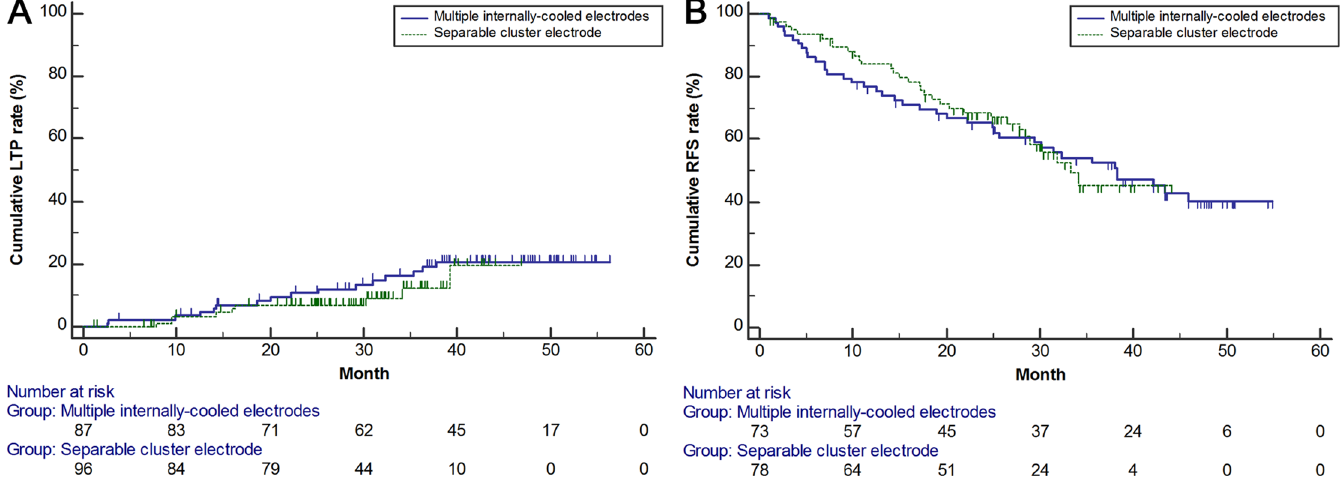
Fig 5. Kaplan-Meier curves showing cumulative (A) local tumor progression and (B) recurrence-free survival rates after switching RFA of HCC, in the separable cluster electrode group and multiple internally-cooled electrode groups ( p = .401 and p = .881, respectively).